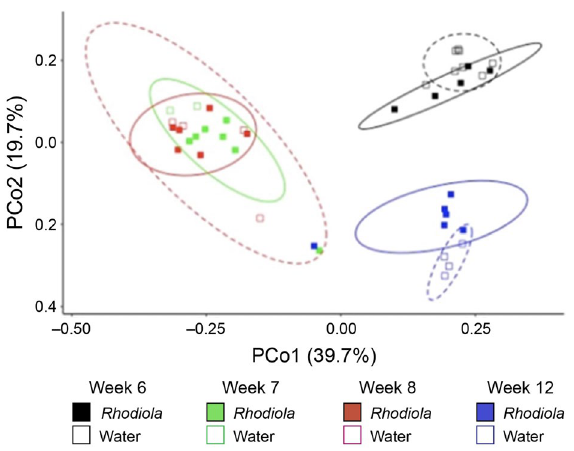
Figure 6. Effects of Rhodiola rosea on the fecal microbiome of db/db mice. Bray–Curtis principal coordinate ordination of the data from Supplemental Fig. 1. The corresponding PERMANOVA (Table 1) identifies significant differences in microbiota composition with treatment and time. The number of fecal samples from different mice analyzed is n = 5 ( R. rosea week 6), n = 7 ( R. rosea week 7), n = 6 ( R. rosea week 8), n = 6 ( R. rosea week 12), n = 8 (water week 6), n = 2 (water week 7), n = 4 (water week 8), and n = 4 (water week 12).